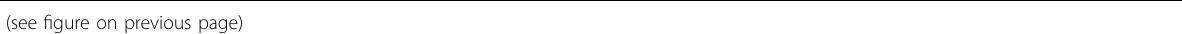
a weighing scale every 2 days. c Food intake was measured by weighing the remaining chow. d Gonadal WAT weight was measured after the 10- week experimental diet period. e The adipocyte size in gonadal WAT sections was determined by staining with hematoxylin and eosin (H&E). Size measurements were performed using ImageJ software. f Inguinal WAT weight was measured after the 10-week experimental diet period. g The adipocyte size of inguinal WAT sections was determined by staining with H&E. Size measurements were performed as above. h Gonadal WAT and inguinal WAT were collected, and tissue lysates were prepared as described in the “ Materials and methods ” . The mRNA expression of FABP4 and FASN was detected by qPCR analysis. β -actin was used as a normalization control. Data are presented as the mean ± SD; * P < 0.05 and *** P < 0.001